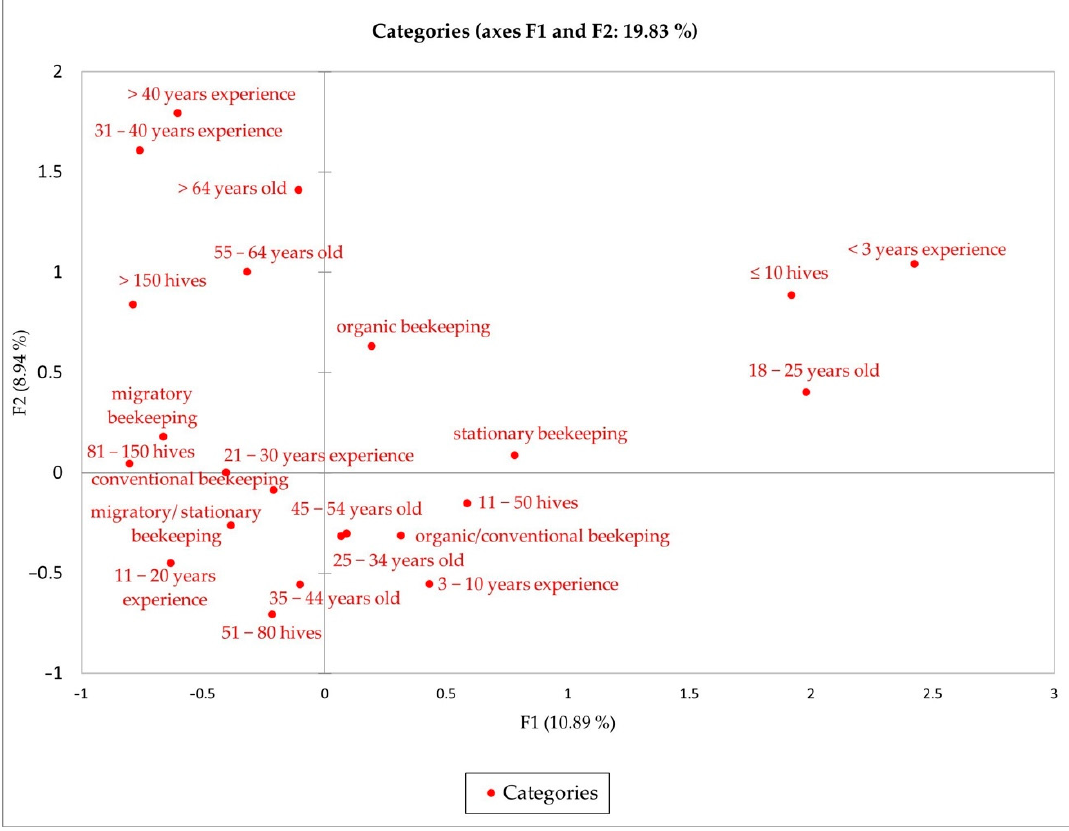
Figure 4. Multiple correspondence analysis (MCA) illustrating two dimensions, created by using the following variables: number of hives, experiences in beekeeping, beekeepers’ age, type of beekeeping.